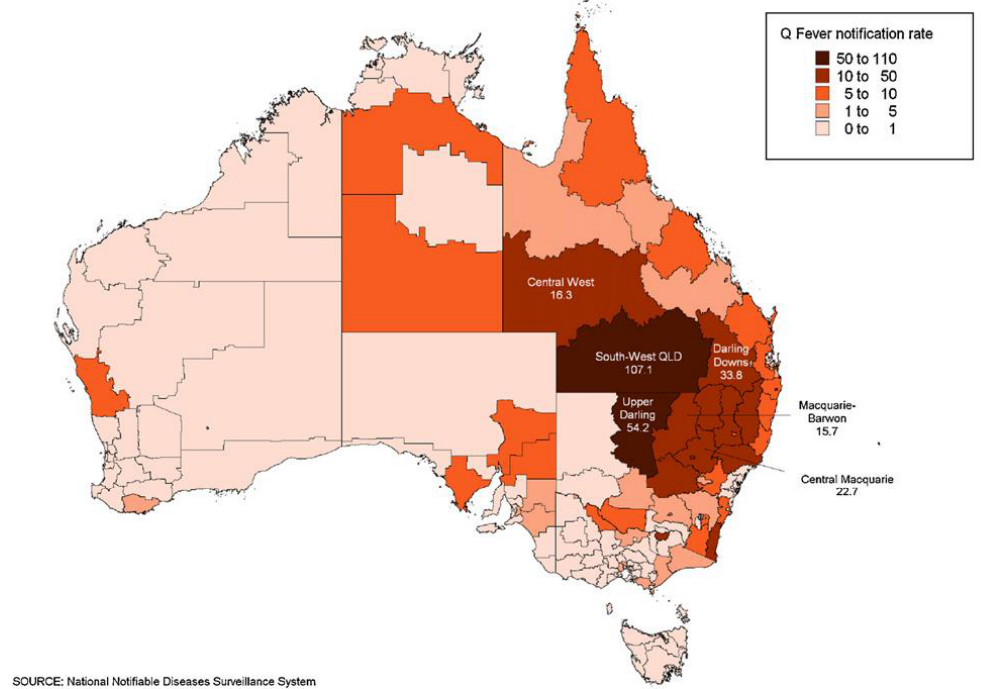
Figure A2. Acute Q fever infection, bacteraemia, and serological responses [16]. Figure A1. Q fever notification rates (per 100,000) by ABS Statistical Subdivision (2006) [15].